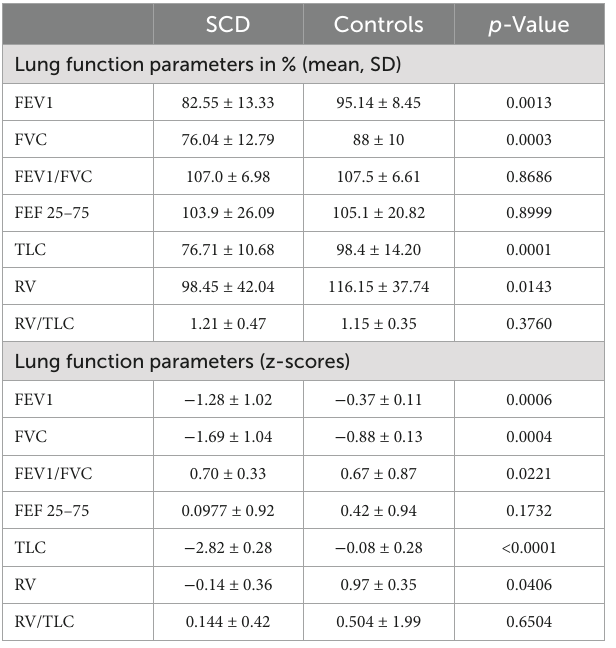
TABLE 2 Lung function parameters in percentage values and z-scores. SCD